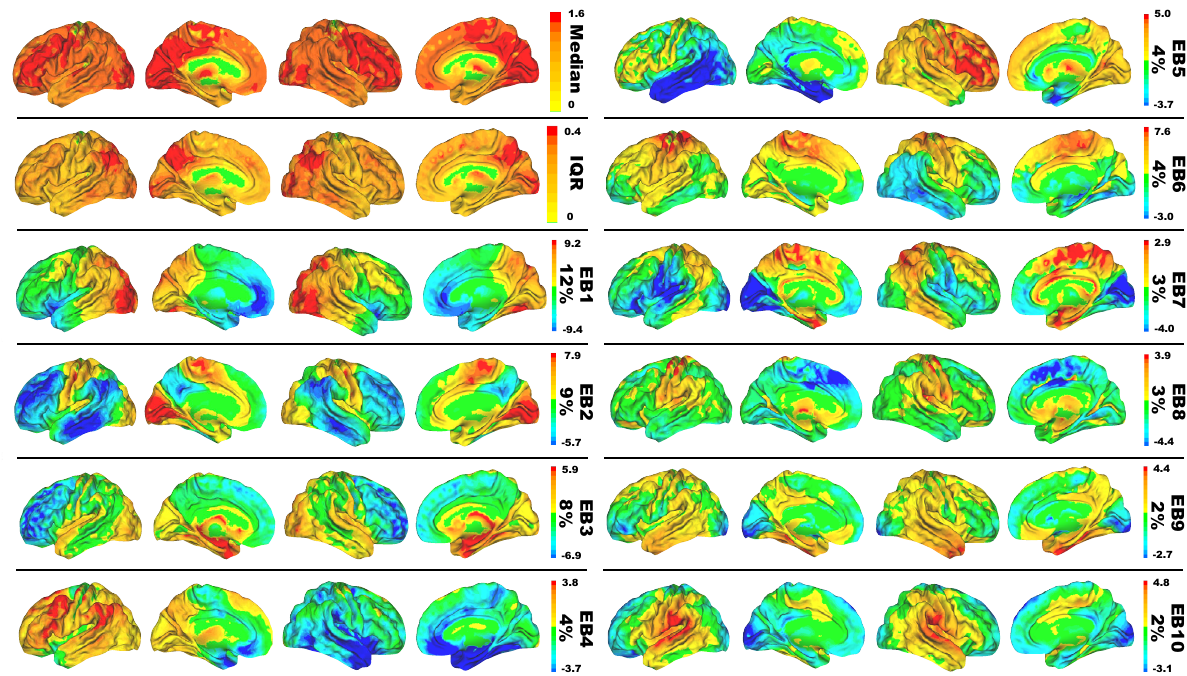
Fig. 1 Surface renderings of glucose eigenbrains. Eigenbrain decomposition of glucose uptake in 423 Alzheimer ’ s patients reveals a low-dimensional set of large-scale patterns that explain 51% of the variance among patients. Surface renderings of median, interquartile range (IQR), and eigenbrain (EB) intensities for the fi rst 10 eigenbrains are displayed. The percentage of variance explained by each is listed to the right of the color bar of arbitrary